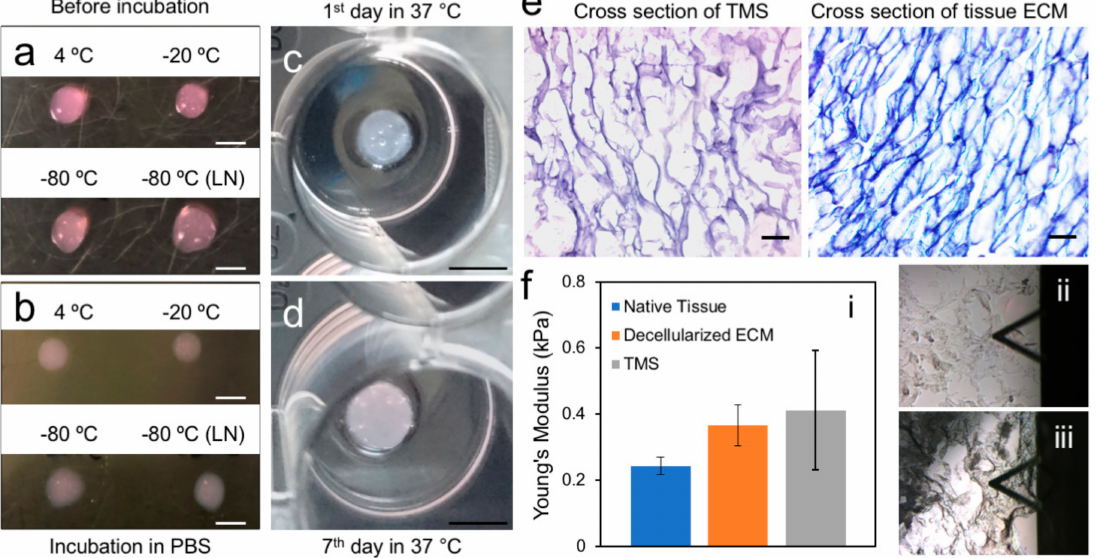
Figure 2. Physical and structurally properties of the porcine breast ECM hydrogel and porous TMS. ( a ) The ice-cold ECM hydrogel stored under different conditions (hydrogels kept in − 20 ◦ C and − 80 ◦ C were thawed in ice at 4 ◦ C) dispensed on the clean and dry plate before polymerization tested and subjected for polymerization at 37 ◦ C for 30 min. ( b ) The polymerized hydrogel was immersed in 1 × PBS or DMEM and placed in 37 ◦ C incubator (5% CO 2 ) for stability test. Scale bars, 4 mm for ( a , b ). ( c , d ) The sustainability of the porous scaffolds generated from the ECM hydrogel was assessed by submersing the scaffolds in PBS or DMEM and incubation at 37 ◦ C (5% CO 2 ) for 7 days. Scale Bars, 6 mm. ( e ) H&E staining of the cross sections of the porous scaffolds and decellularized porcine breast fatty tissue ECM. Scale bars, 100 µ m. ( f ) AFM measurement of the mechanical properties of porcine native breast tissues, decellularized breast ECM, and porous TMS: ( i ) Young’s moduli of the samples; ( ii ) and ( iii ) Illustrations of the positions of the probe tips on the decellularized ECM and TMS samples,